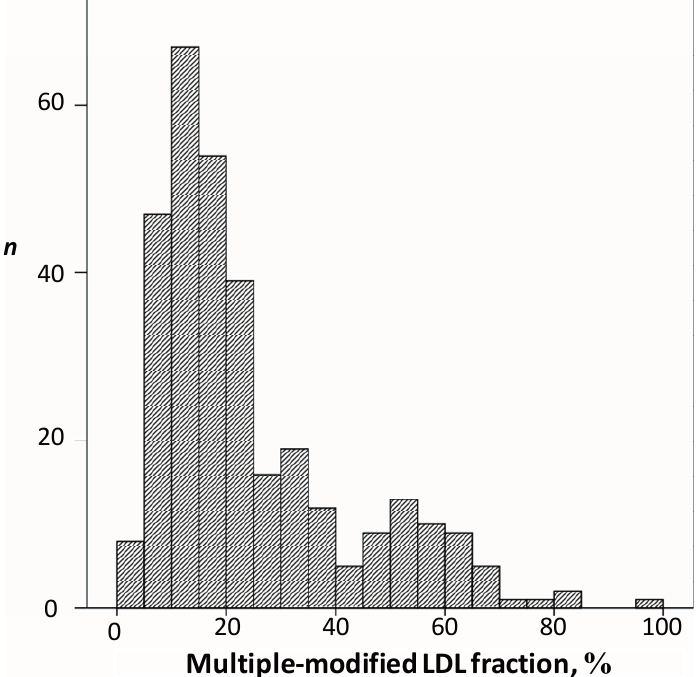
Figure 3. The frequency of distribution of multiple-modified LDL (mmLDL) depending on their subfraction content in total LDL from sera of 318 men (aged 40–78) asymptomatic for ischemic heart disease. The percentage of mmLDL fraction in total serum LDL is presented in the horizontal axis. The vertical axis displays the number of observations ( n